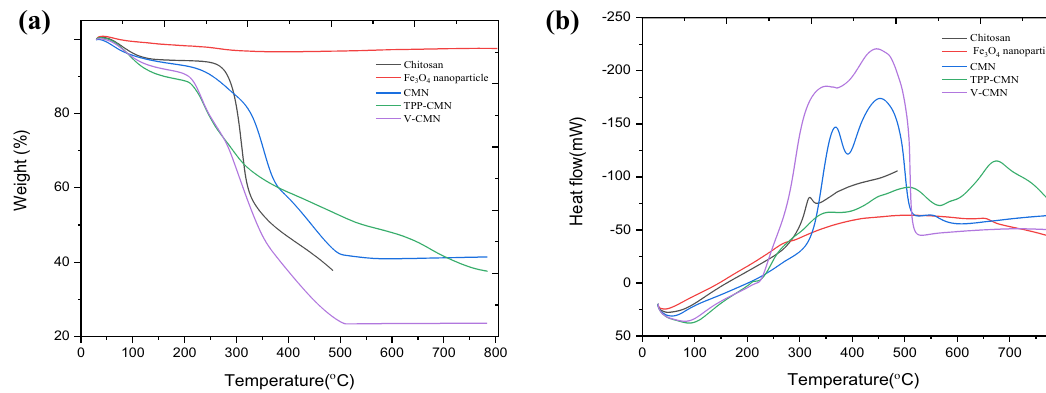
Figure 3. ( a ) TGA curves and ( b ) DTA curves of chitosan, Fe 3 O 4 nanoparticle, CMN, TPP-CMN and